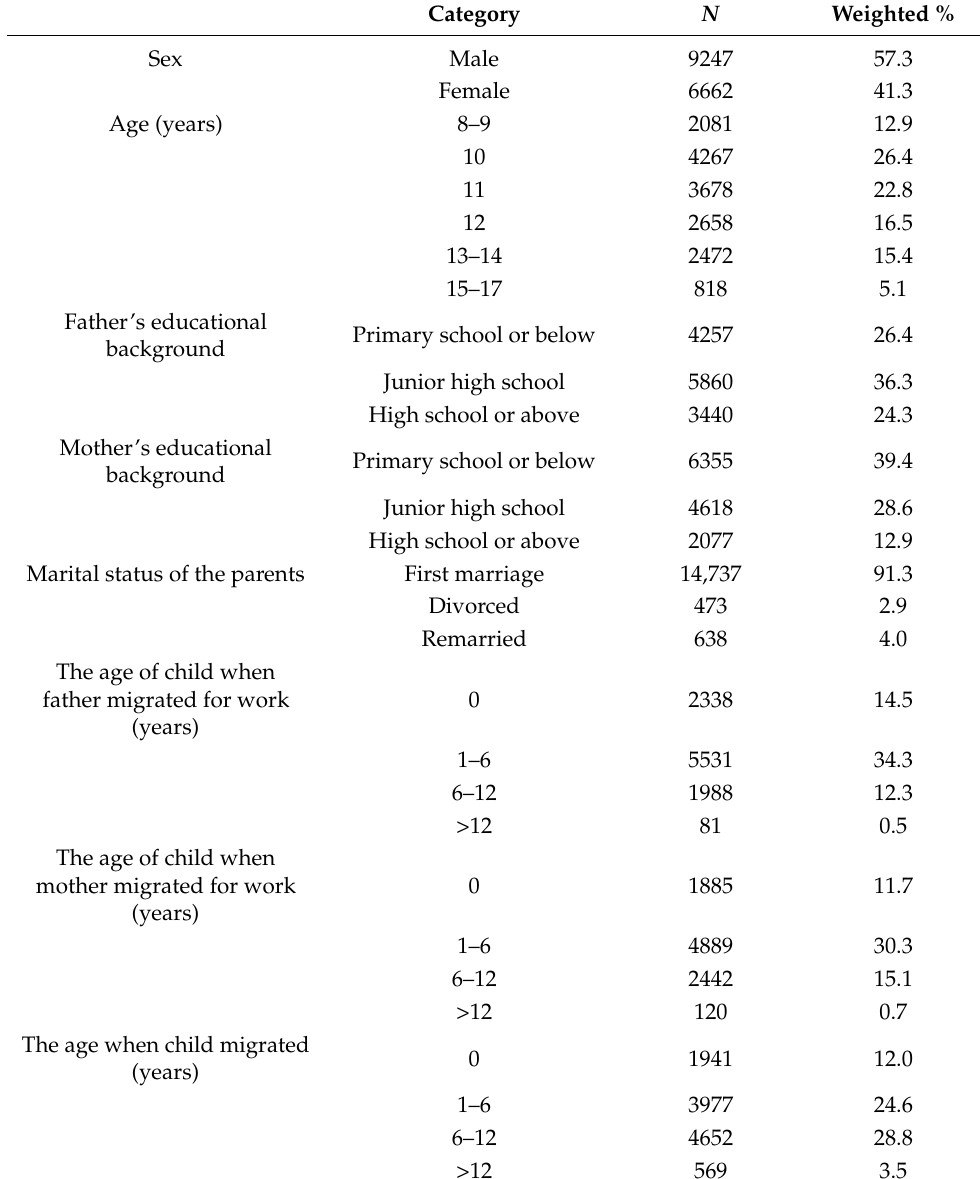
Table 1. Sociodemographic features of the participants ( n =